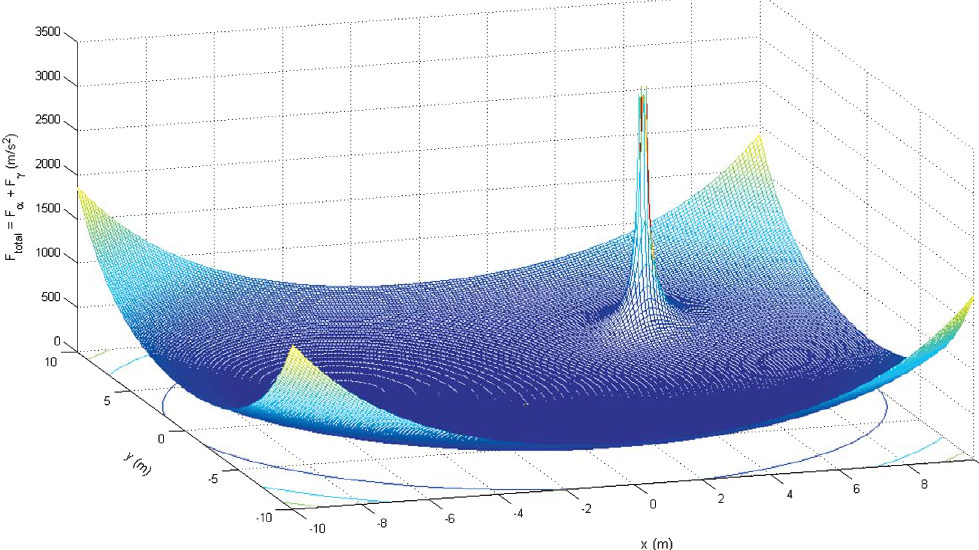
Fig. 8. 3 D potential fields combining F γ + F α , at < − 5 , 0 > γ is located, and at coordinates (4 , 5) an obstacle is